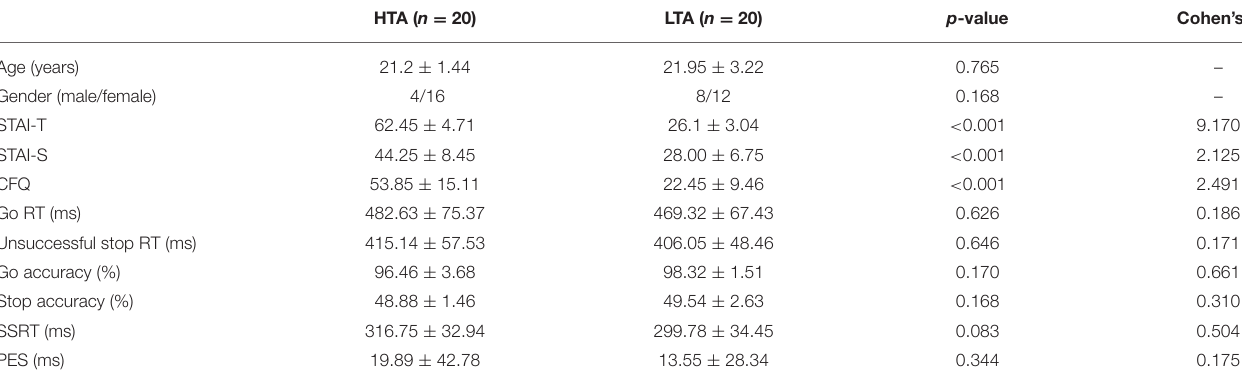
TABLE 1 | Demographic and behavioral data (mean ± SD) in subjects with higher (HTA) and lower trait anxiety